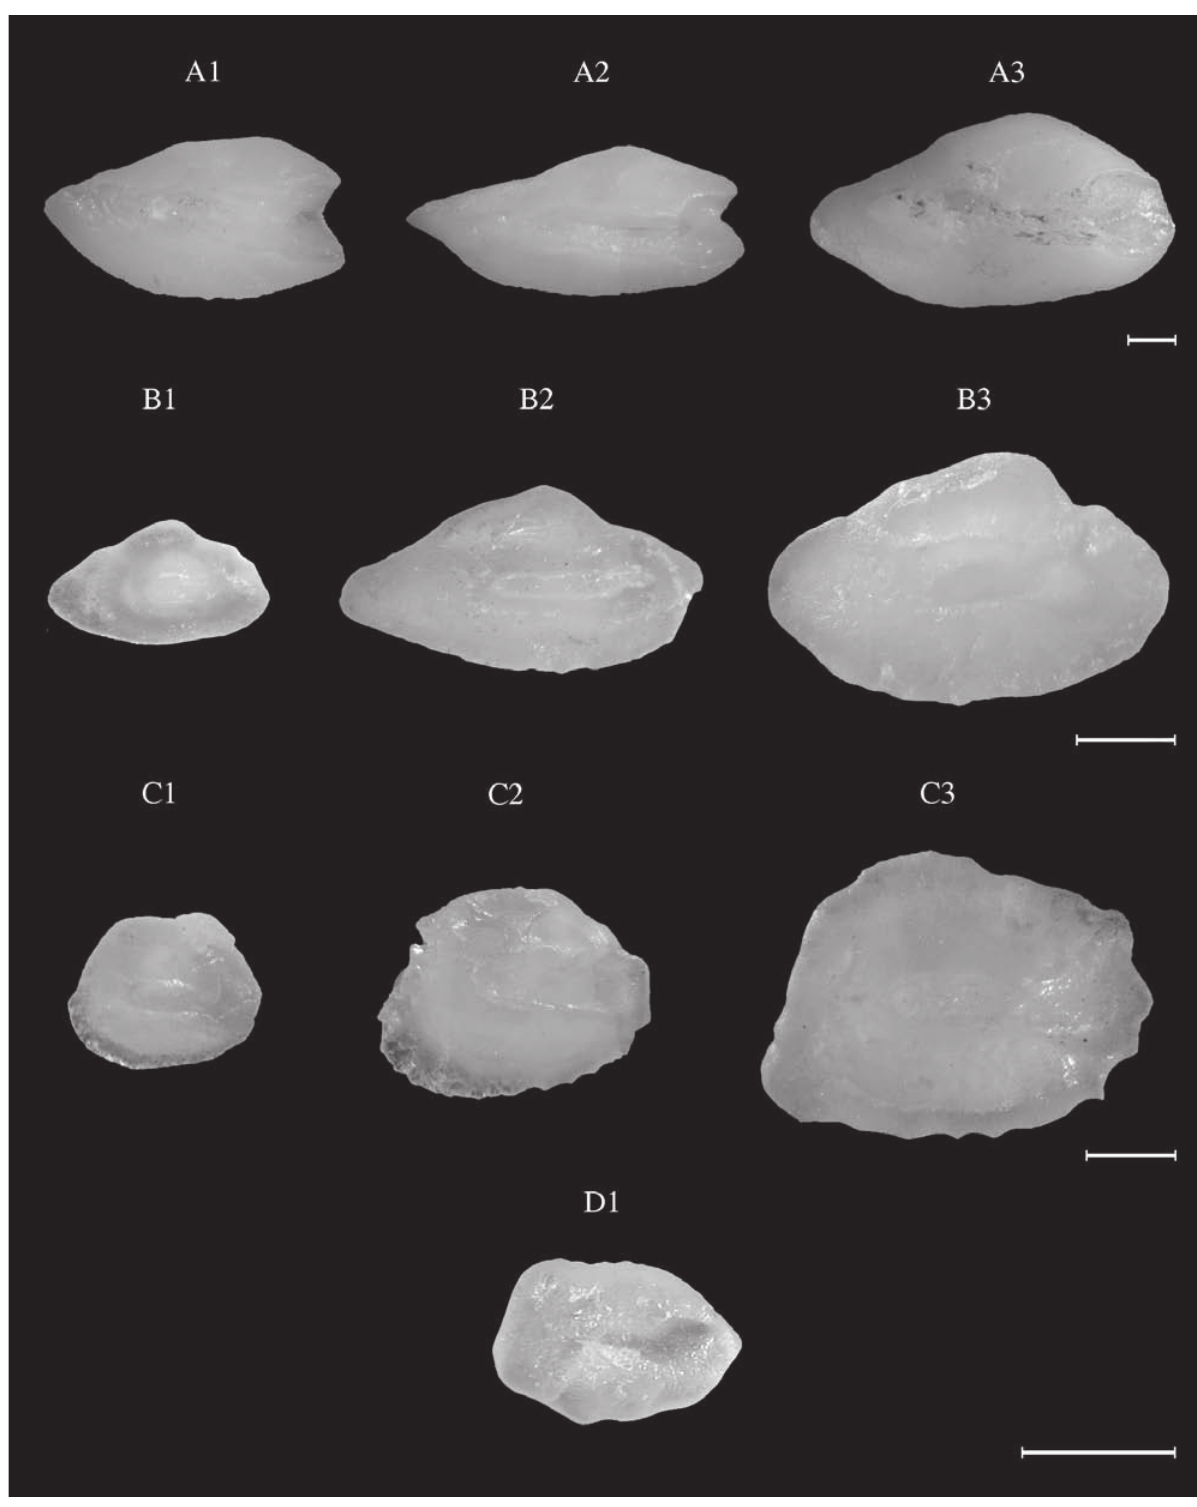
Fig. 12. – Muraena helena (CEA). TL: A1, 90.0 cm; A2, 95.8 cm; A3, 108.0 cm. Simenchelys parasitica (CEA). TL: B1, 26.3 cm; B2, 43.5 cm; B3, 43.8 cm. Syanaphobranchus affinis (CEA). TL: C1, 36.5 cm; C2, 52.4 cm; C3, 70.0 cm. Apterichtus caecus (WM). TL: D1, 42.5 cm. Scale bar = 1